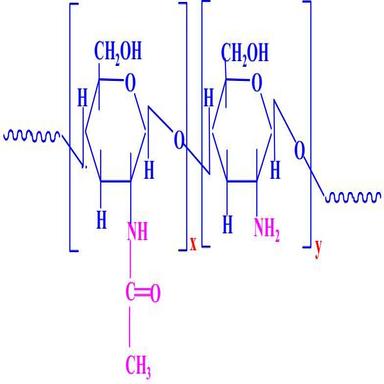
Synthetic procedure of N-doped carbon coated Li2ZnTi3O8 samples.